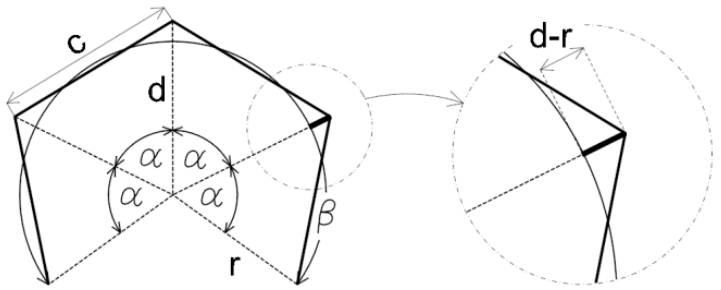
Figure 4. Changing the arc to a polygon, n = 4.